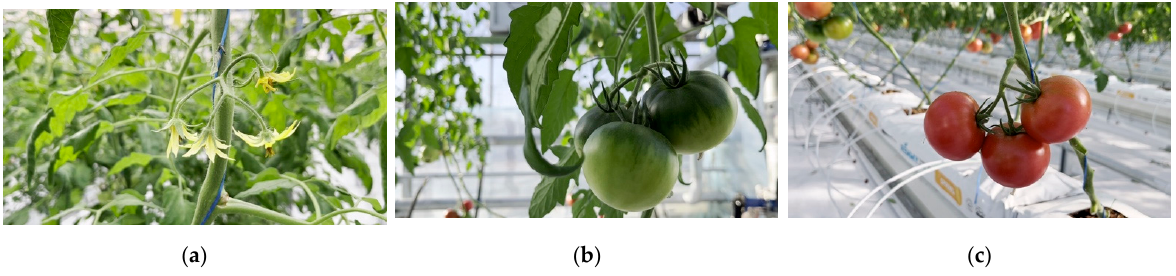
Figure 3. Images in the dataset used for object detection model training and testing: ( a ) tomato flower; ( b ) unripe tomatoes ; ( c ) unripe tomatoes. Table 1. The number of targets for each category.